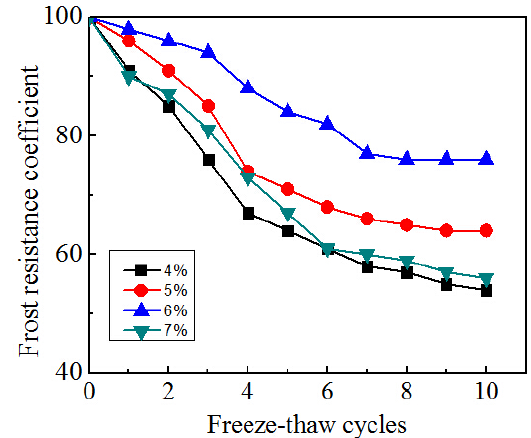
Fig.1. Frost resistance performance of cement stabilized graded stone with different moisture